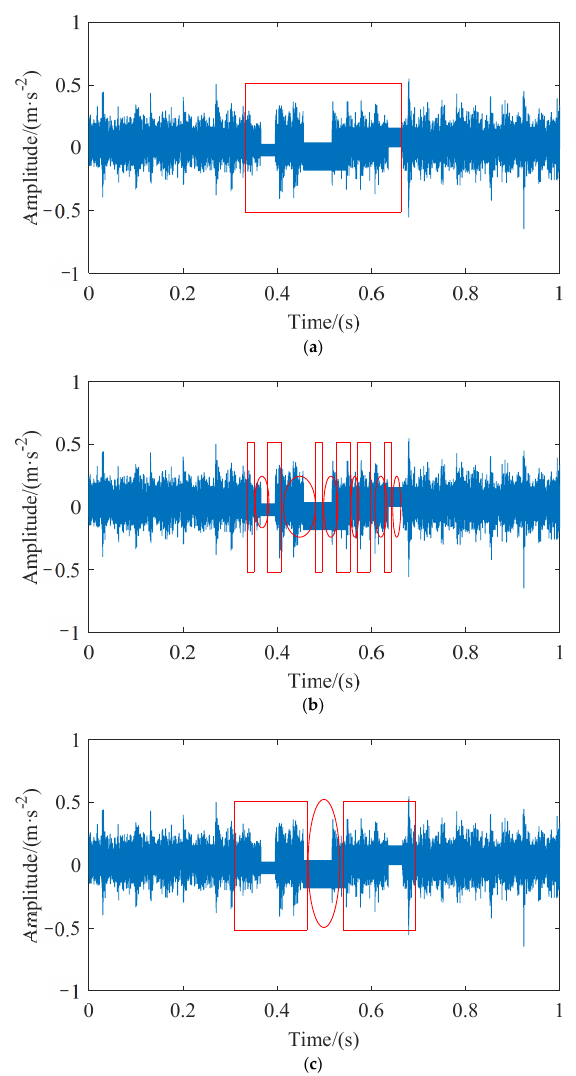
Figure 16. Abnormal data detection results of fan end signal. ( a ) CF-POIF; ( b ) CF-IF; ( c ) CF-LOF.